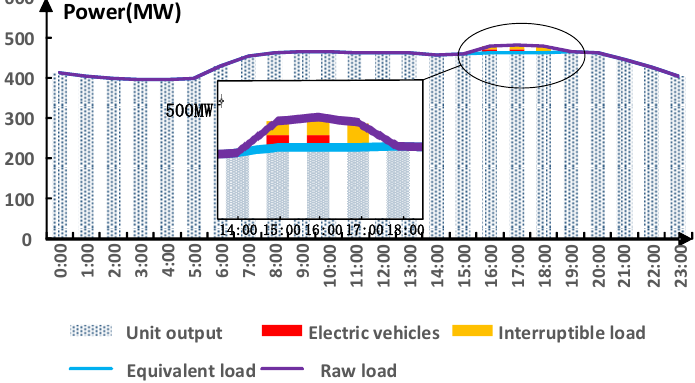
Figure 4. System operation status before and after demand response. Table 5. Loss of energy